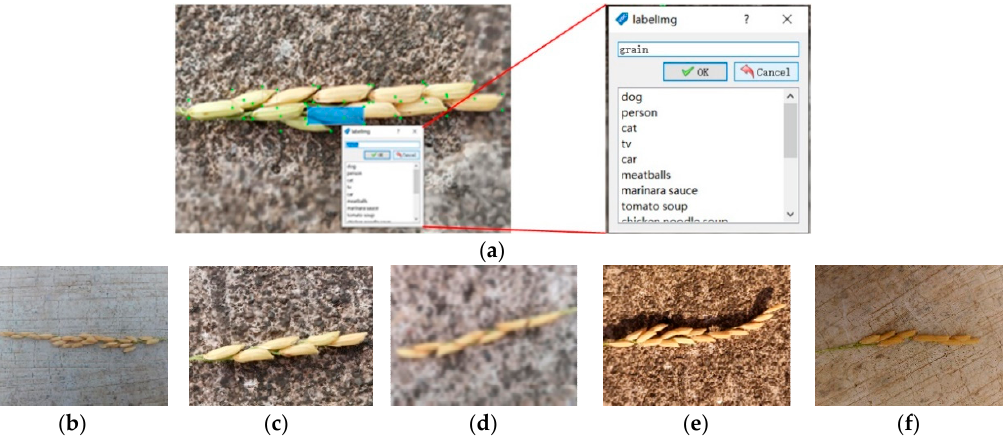
Figure 2. Examples of labeling grains with bounding boxes: ( a ) drawing bounding boxes using the LABELIMG software; ( b ) small scale, ( c ) large scale, ( d ) blurred condition, ( e ) sunny condition with background shadows, ( f ) cloudy condition.